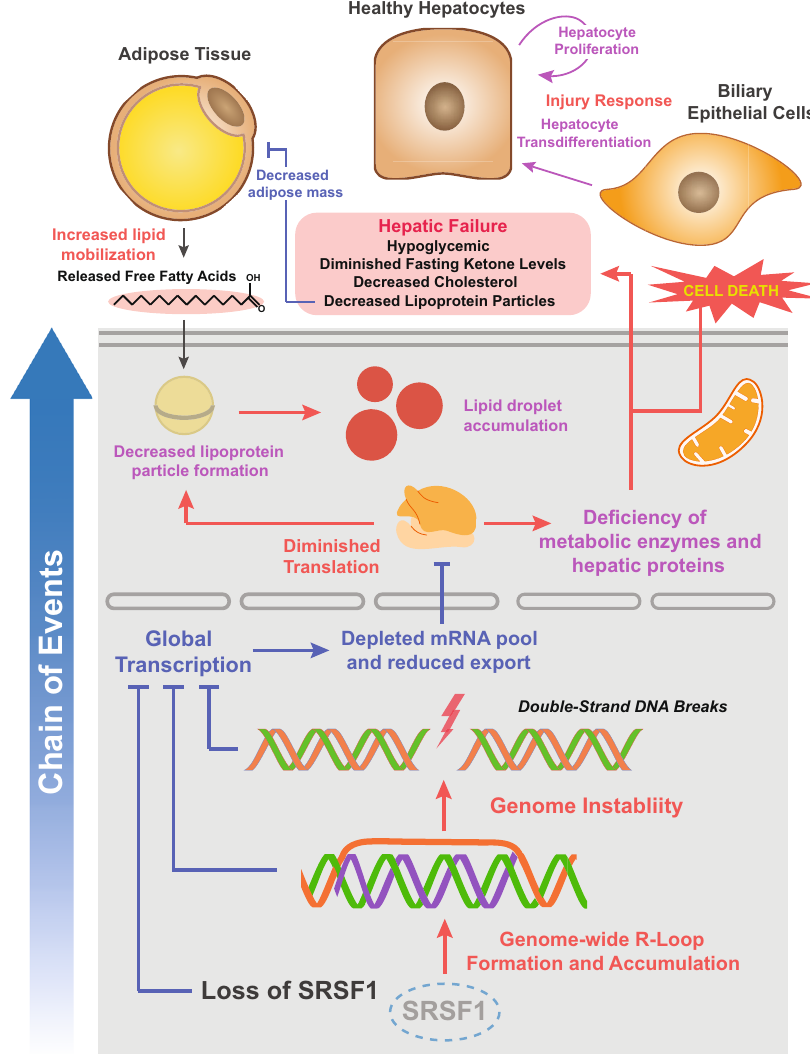
Fig. 10 | Proposed mechanism of cell death in SRSF1-de fi cient hepatocytes. LossofSRSF1initiallyleadstoanoverwhelmingaccumulationofR-loopswithinthe actively transcribed DNA of hepatocytes. This results in widespread DNA damage asunresolved R-loops areprone to double-stranded breaks. Thecombined effects